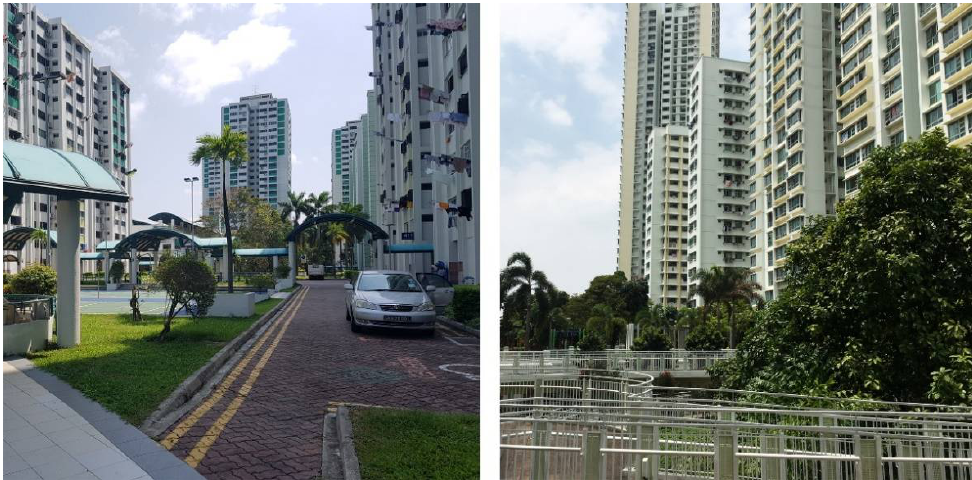
Figure 5. Clementi neighbourhood: precinct 1 (left); precinct 2 (right) (source: by author).